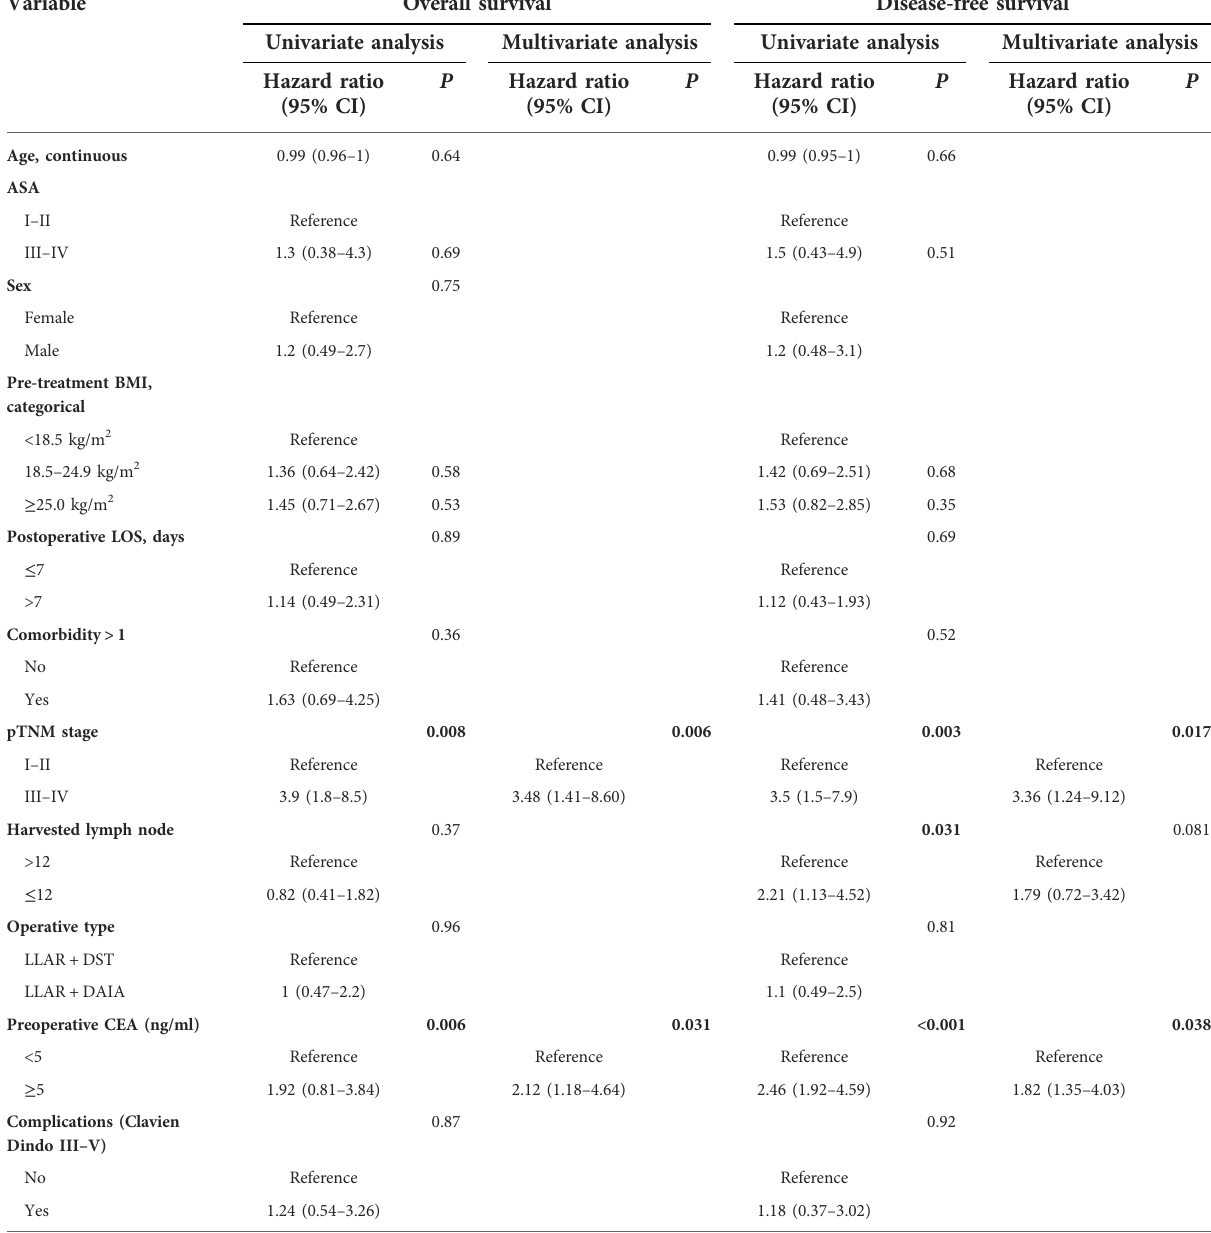
TABLE 3 Univariate and multivariate analysis for overall survival and disease-free survival in matched